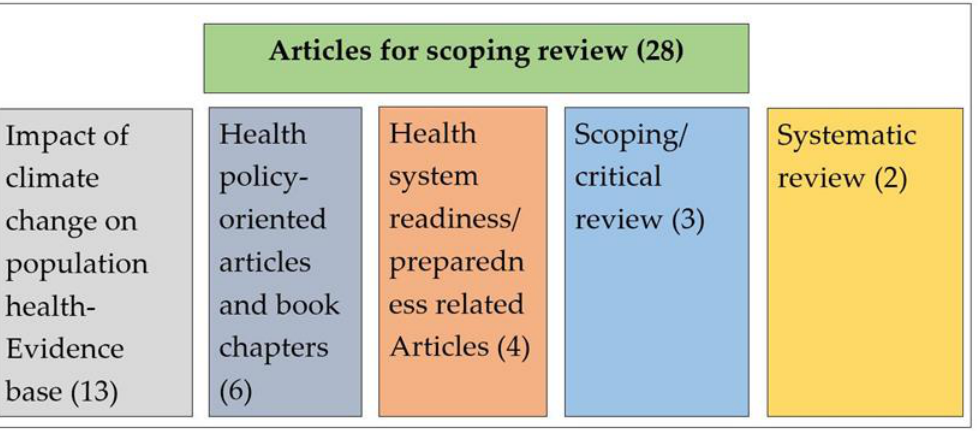
Figure 2. A synthesis of selected articles.